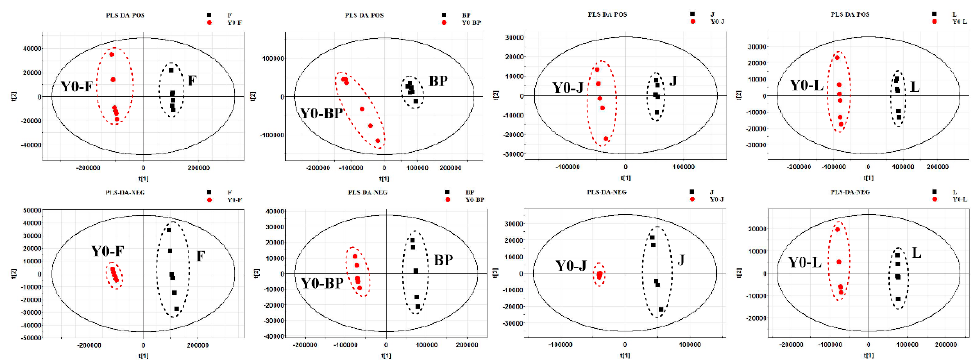
Figure 7. PLS-DA score plots of the transgenic group and control group in ESI positive and negative ion mode.